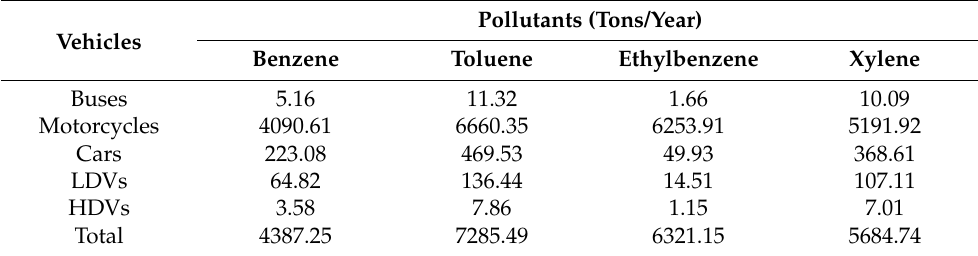
Table 1. Emission from on-road sources for five transportation means